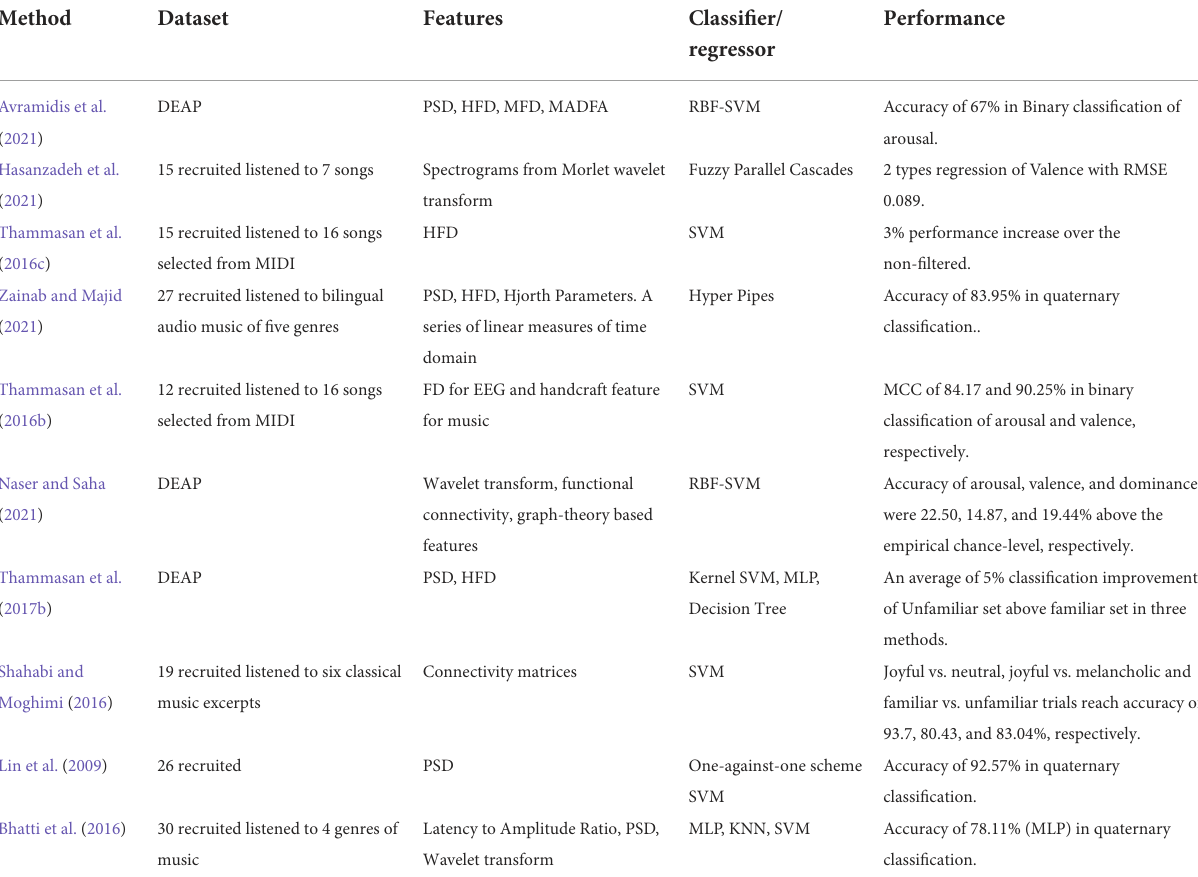
TABLE 3 Details of music emotion recognition algorithms based traditional